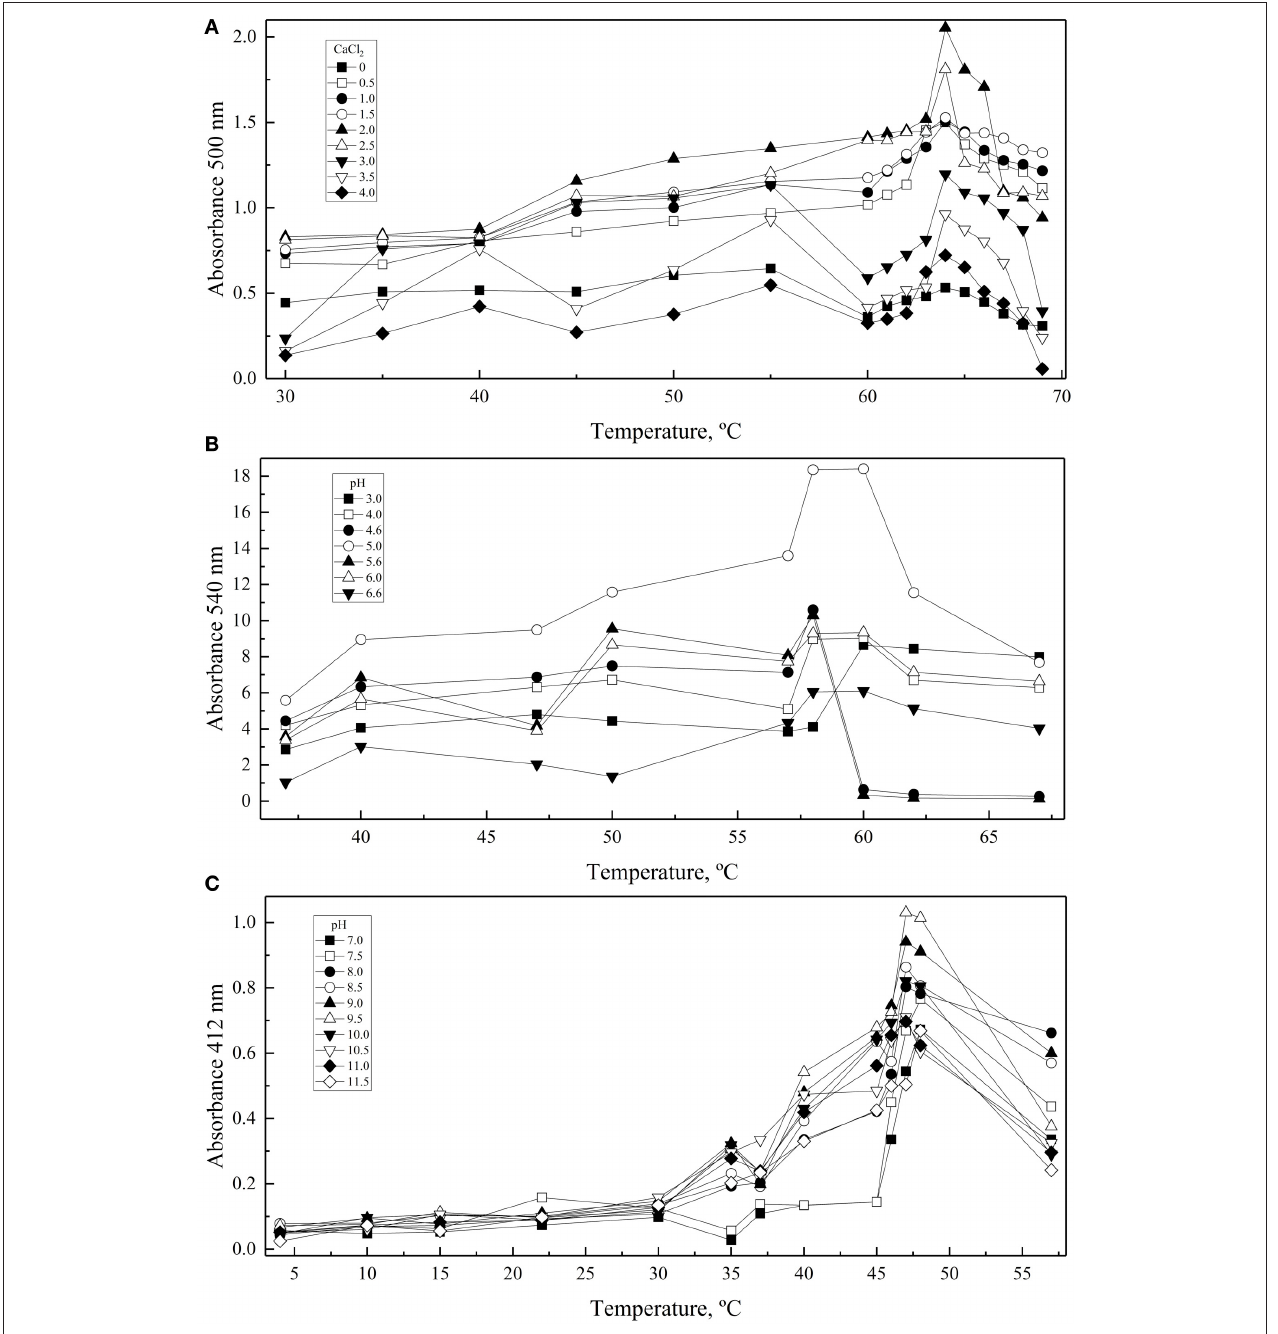
FIGURE 3 | Effect of physical-chemical factors on enzyme activity. Enzymatic reactions were conducted varying the CaCl 2 , pH, and temperature in each central composite design: CaCl 2 and temperature for GOD (A) , and pH and temperature for Inv (B) and ALP (C) . Each point corresponds to the maximum values of absorbance obtained from progress curves performed at each condition. Total amounts of enzyme used in each assay were 15, 39, or 39 ug of GOD, Inv or ALP, respectively. The substrate concentration used was 280, 100, or 5mM of glucose, sucrose or pNPP.